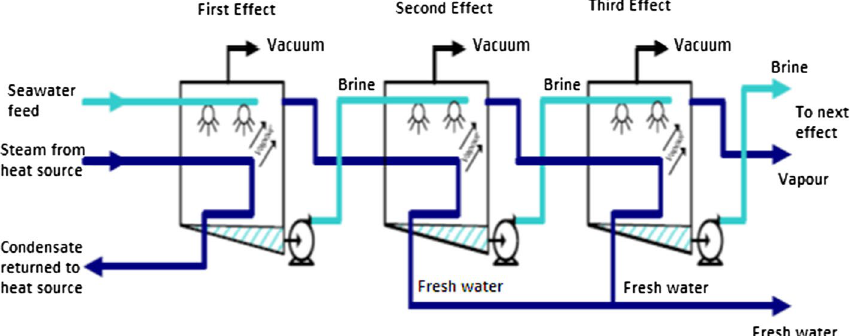
Fig. 2 Diagram of a multieffect distillation